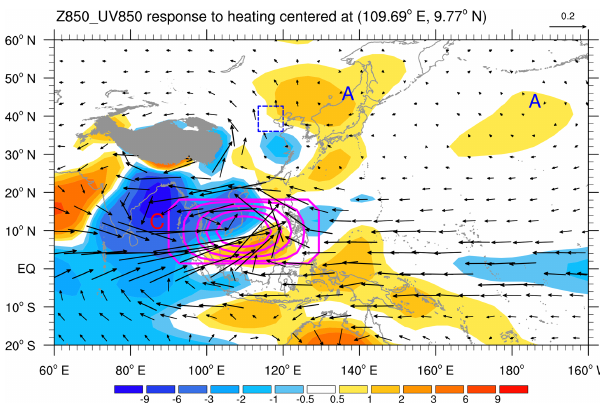
Figure 12. The response of Z850 (shaded; 10gpm) and UV850 (vectors; ms − 1 ) in H_WNP. The magenta contours indicate the imposed idealized heating. The blue dashed box delineates the re- search domain of the BTH region. The gray shaded area denotes the Tibetan Plateau. The letter A (C) represents the center of the anticyclonic (cyclonic) anomaly.